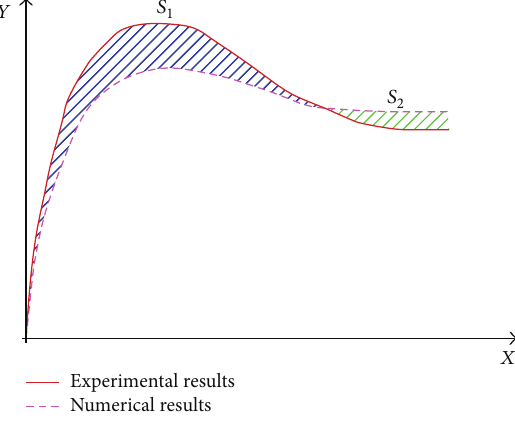
Figure 7: Concept of error